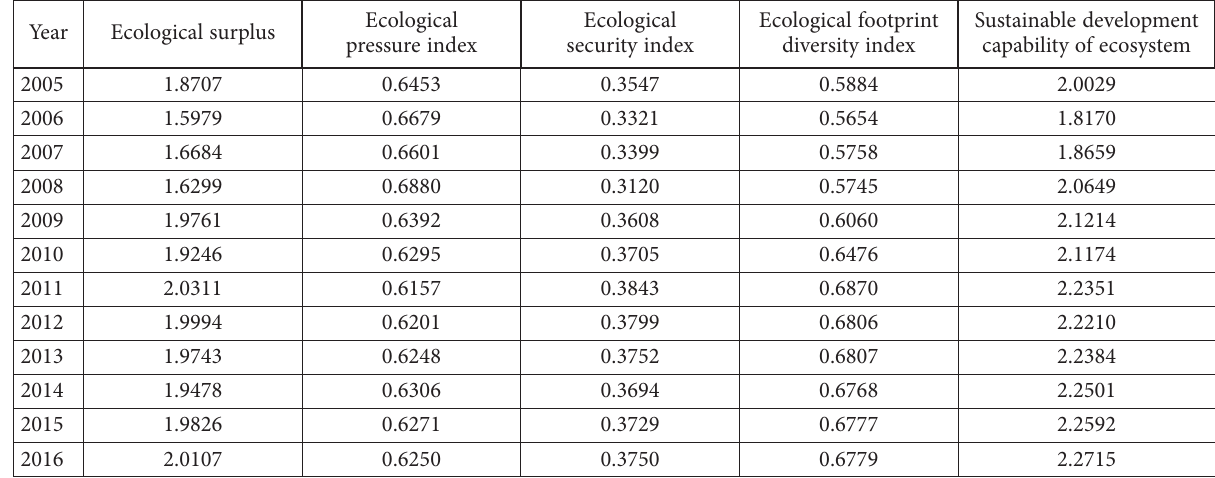
Table 1. Multiple ecosystem status index of Pingtan Island